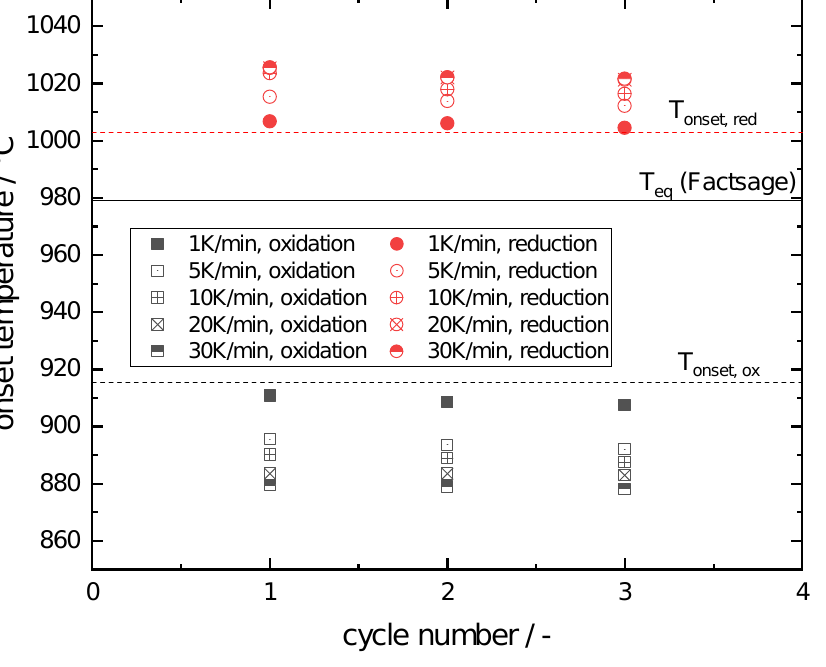
Figure A2. Obtained onset temperatures of reduction and oxidation of the investigated manganese–iron oxide for 3 consecutive cycles in a thermogravimetric analyzer, applying an oxygen concentration of 20% at different heating and cooling rates: The effective onset temperatures (dashed lines) and the thermodynamic equilibrium (solid line) are displayed as